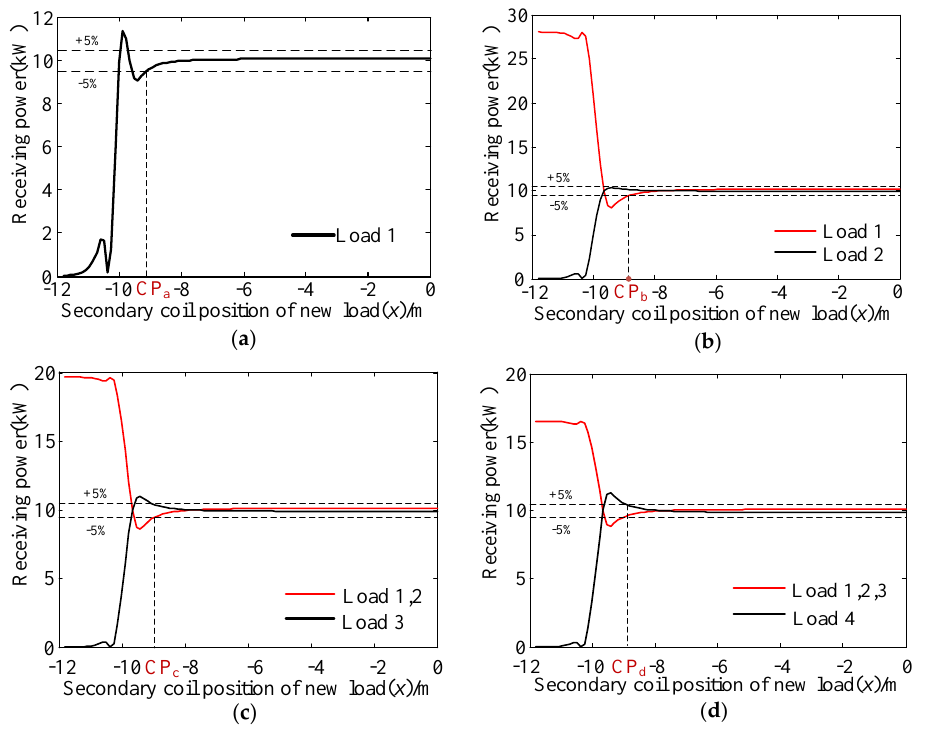
Figure 8. The curves of received power of each load versus position variation of new load: ( a ) one-load system; ( b ) two-load system; ( c ) three-load system; ( d ) four-load system.